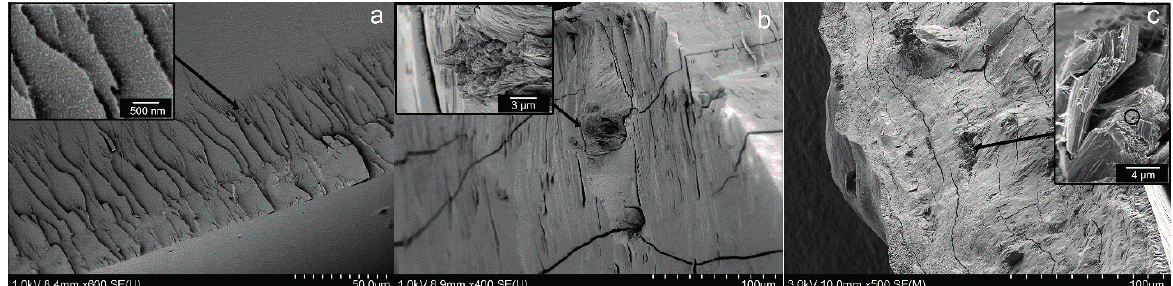
Figure 1. SEM images of ( a ) FSBP ( b ) NC 20 ( c ) NC 30 films, with insets highlighting the characteristics of the surface morphologies.